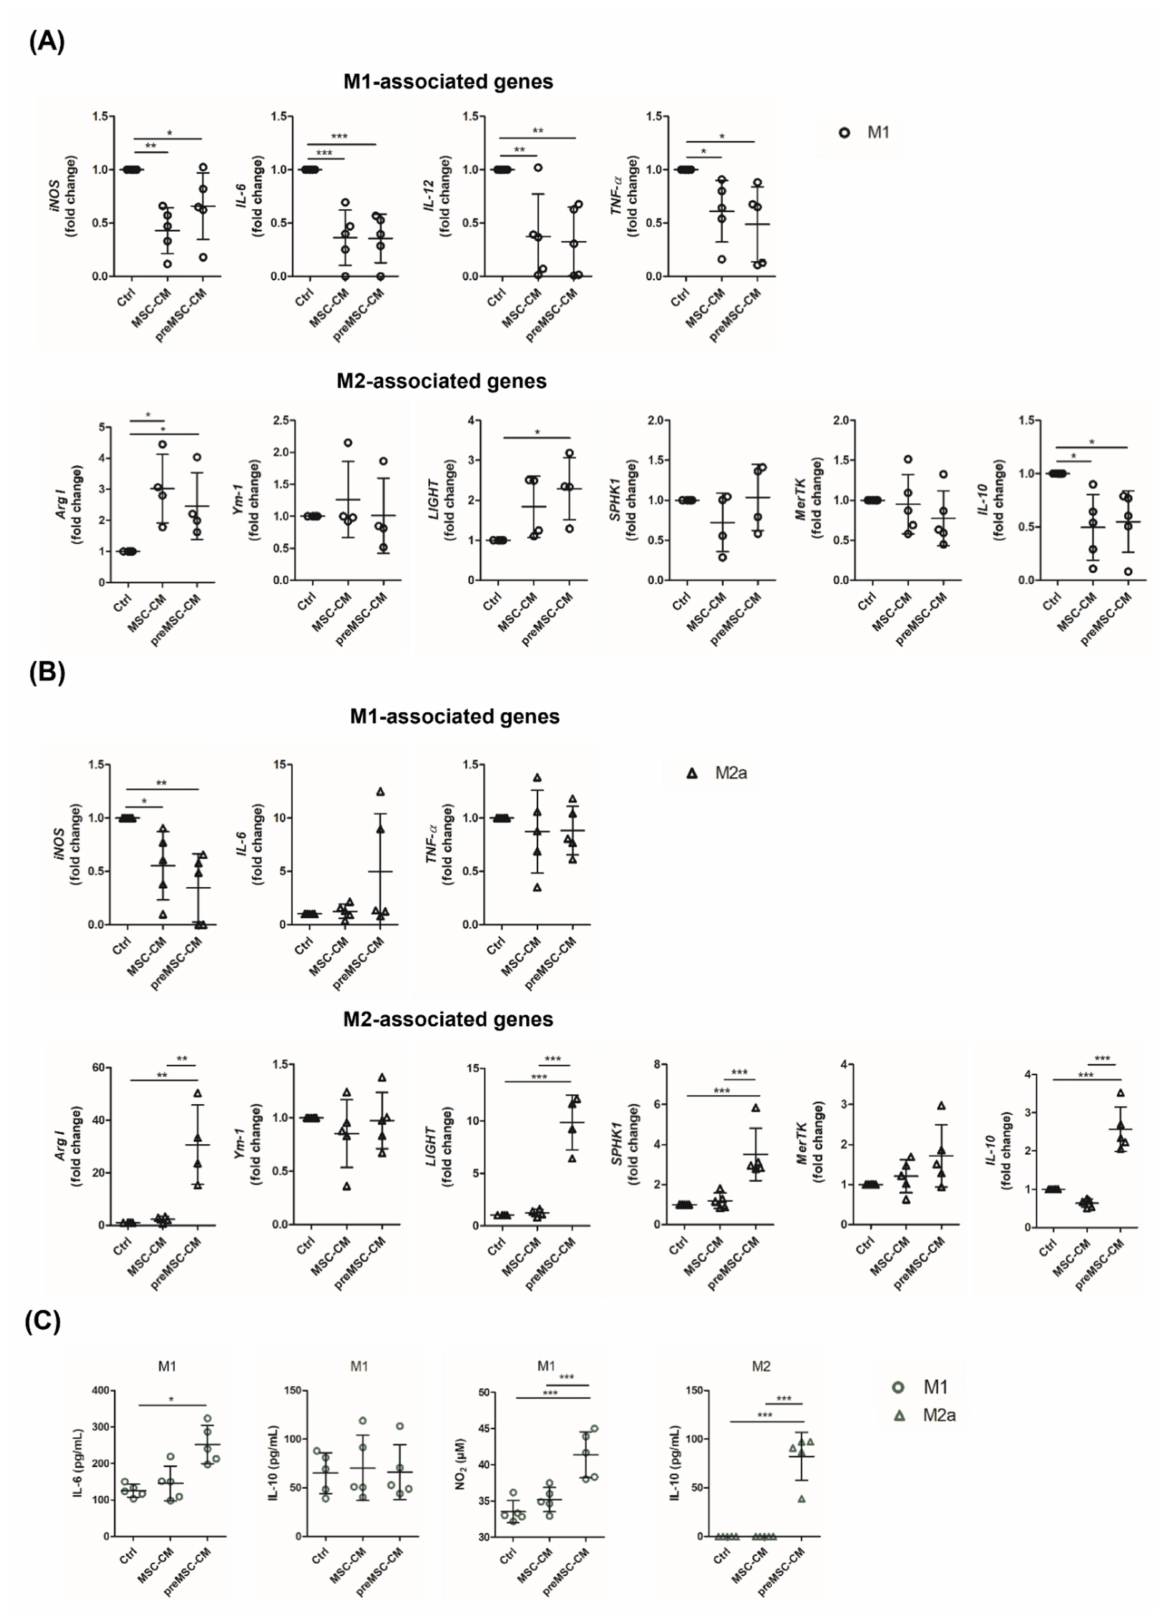
Figure 2. Effect of MSC-CM and preMSC-CM on macrophage reprogramming. Bone marrow-derived macrophages were polarized toward an M1-like or M2a-like phenotype for 24 h. Then, the medium was replaced and 20% (pre)MSC-CM was added to the culture medium. Cells were incubated for